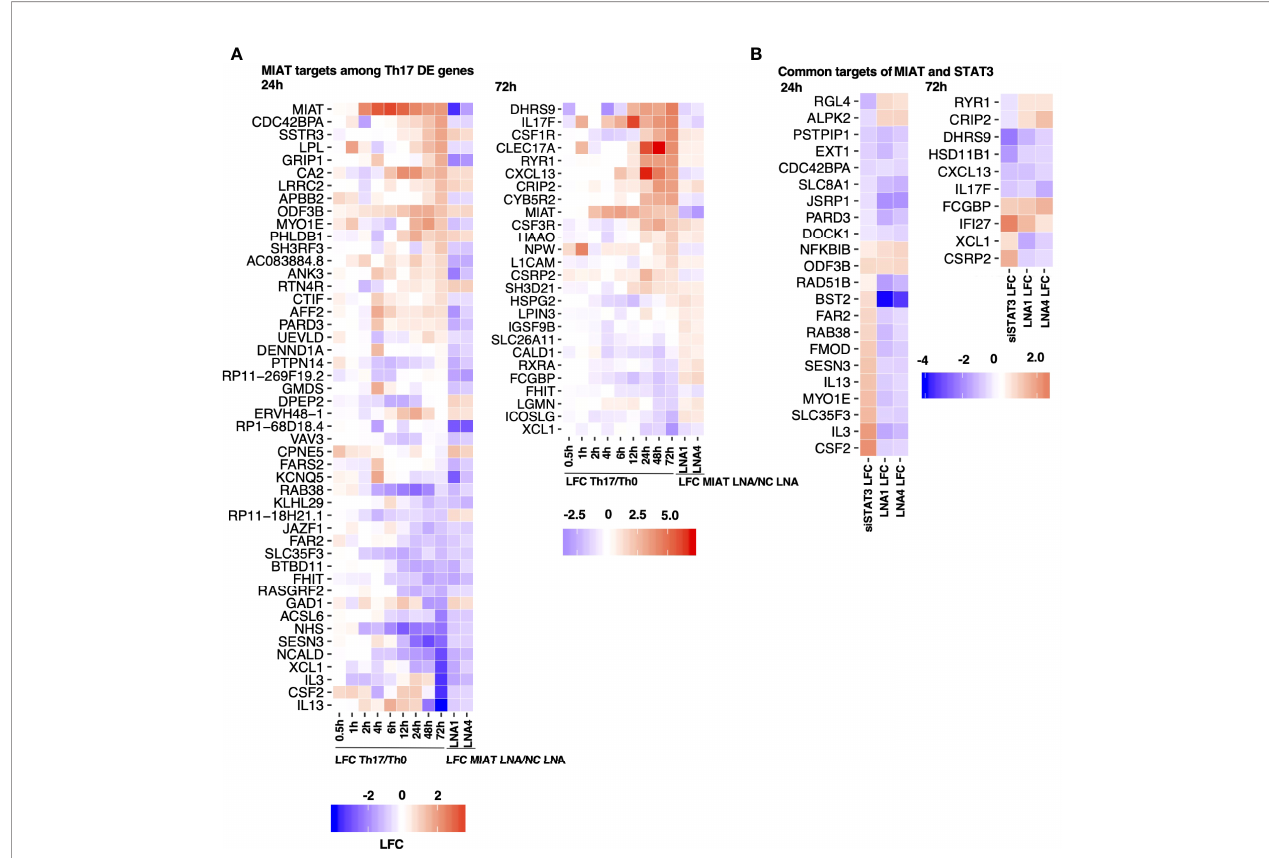
FIGURE 5 | STAT3 and MIAT Have Overlapping and Unique Targets during Th17 Differentiation. (A) A subset of MIAT-regulated genes that are DE also during human Th17 cell differentiation (7). 24- (left) and 72-h (right) MIAT-regulated genes are plotted separately. The fi rst nine columns show the log fold-change (LFC) of expression between Th17 and Th0 at indicated time points. The remaining two columns show the LFC between MIAT LNA1/4- and NC-treated Th17 samples. (B) Heatmaps represent MIAT target genes that were also regulated by STAT3 siRNA treatment from our previous study (15). Both 24 (left) and 72 h (right) MIAT targets are plotted. The fi rst column shows the LFC of genes upon STAT3 silencing, and the remaining columns show LFC of genes upon MIAT